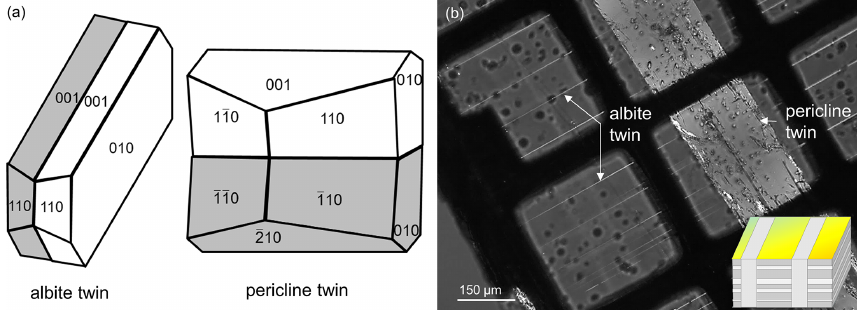
Figure 4. (a) Schematic drawing of an albite and a pericline twin in labradorite. (b) Labradorite that was cut at 90 ◦ to the twinning and the labradorescence under crossed nicols in a polarizing microscope. Besides the pericline twins, there are polysynthetic albite twins that are intersected by the pericline twins at an angle of about 90 ◦ . Note that no albite twins were observed inside the pericline twin. Insert in the bottom-right corner of (b) was taken from Fig.